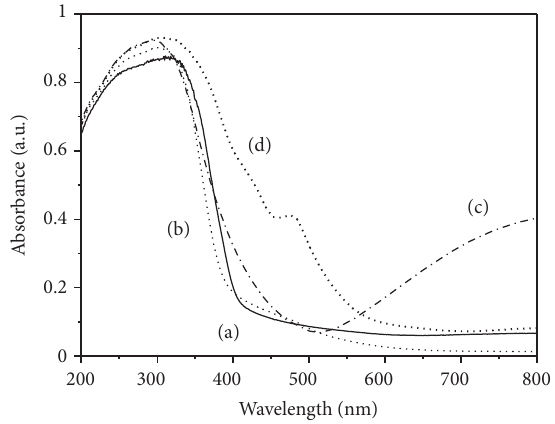
Figure 2: Diffuse reflectance ultraviolet-visible spectra of the (a) nanosize TiO 2 , (b) TNT, (c) Cu-TNT, and (d) Fe-TNT.